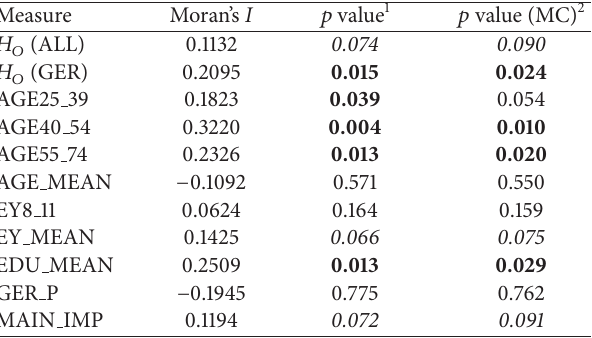
Table 3: Estimated Moran’s 𝐼 values and 𝑝 values of two Moran’s 𝐼 tests for spatial autocorrelation computed for all defined